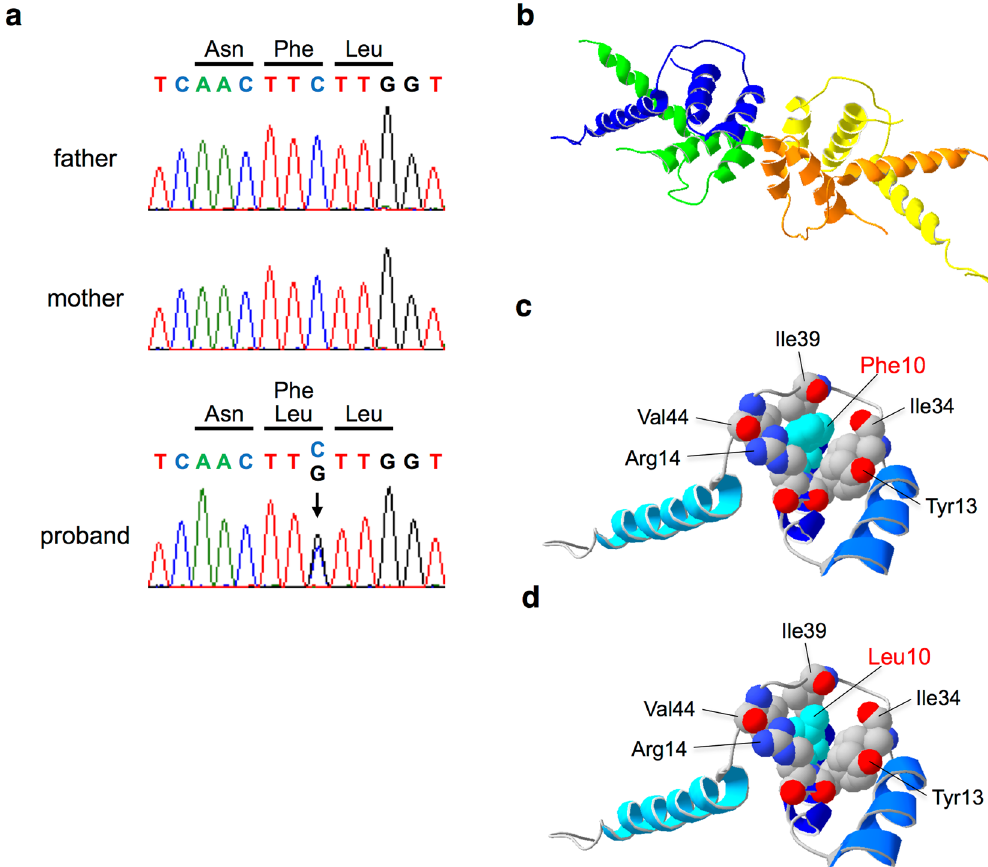
Figure 1. Structural models of TBL1XR1 N-terminal domain (NTD). ( a ) De novo mutation in TBL1XR1 [c.30 C > G (p.Phe10Leu)]. The chromatogram shows the mutation in the TBL1XR1 gene, which is observed in the proband (arrow) but not in the parents. ( b ) Overall structure of a homology model of tetrameric NTD of TBL1XR1. Monomers are depicted in distinct colors. ( c ) A monomer model of the control NTD is depicted as a ribbon model. Important residues are depicted as spheres. Gray, red and blue spheres indicate carbon, oxygen and nitrogen atoms, respectively, although all atoms of Phe10 are colored in cyan for clarity. ( d ) A monomer model of Phe10Leu NTD is depicted as a ribbon model. Leu10 is colored in cyan for